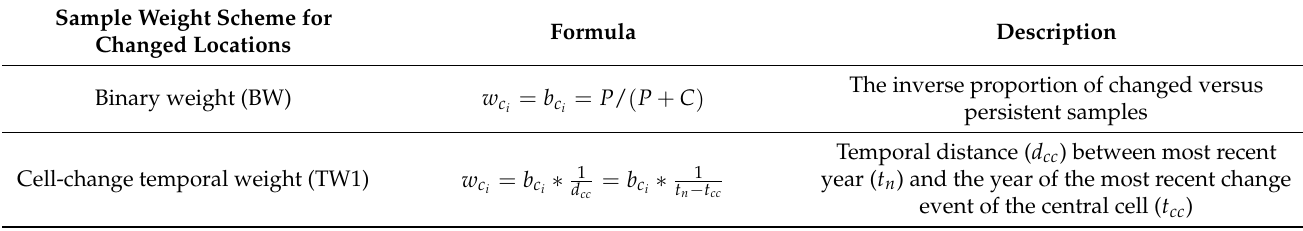
Table 1. Sample weight scheme applied to samples identified as